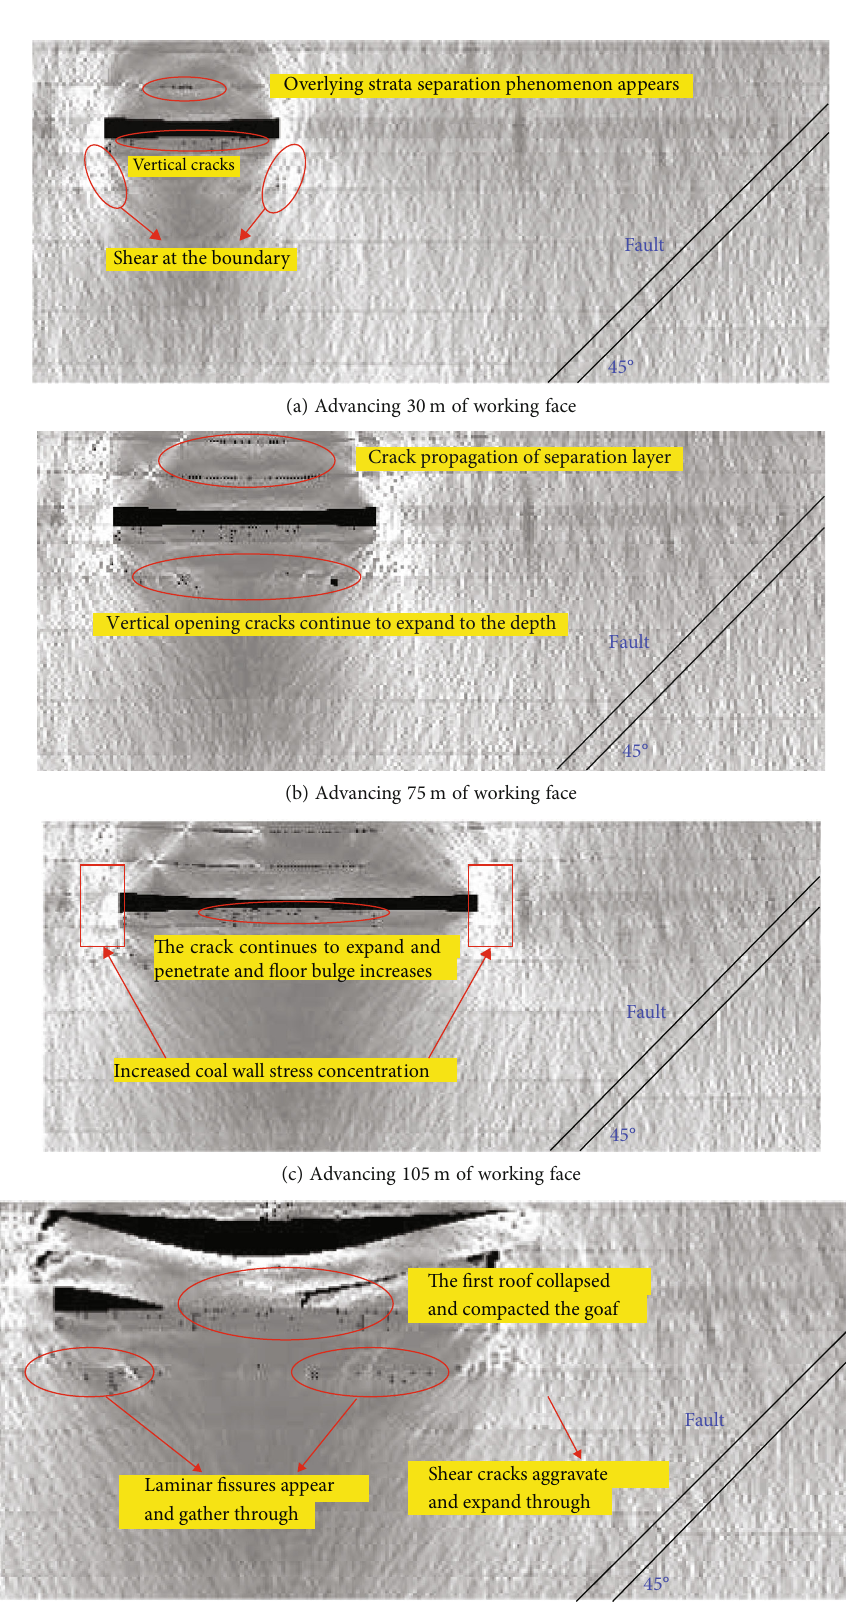
Figure 11: Mining crack evolution process (50 m, project